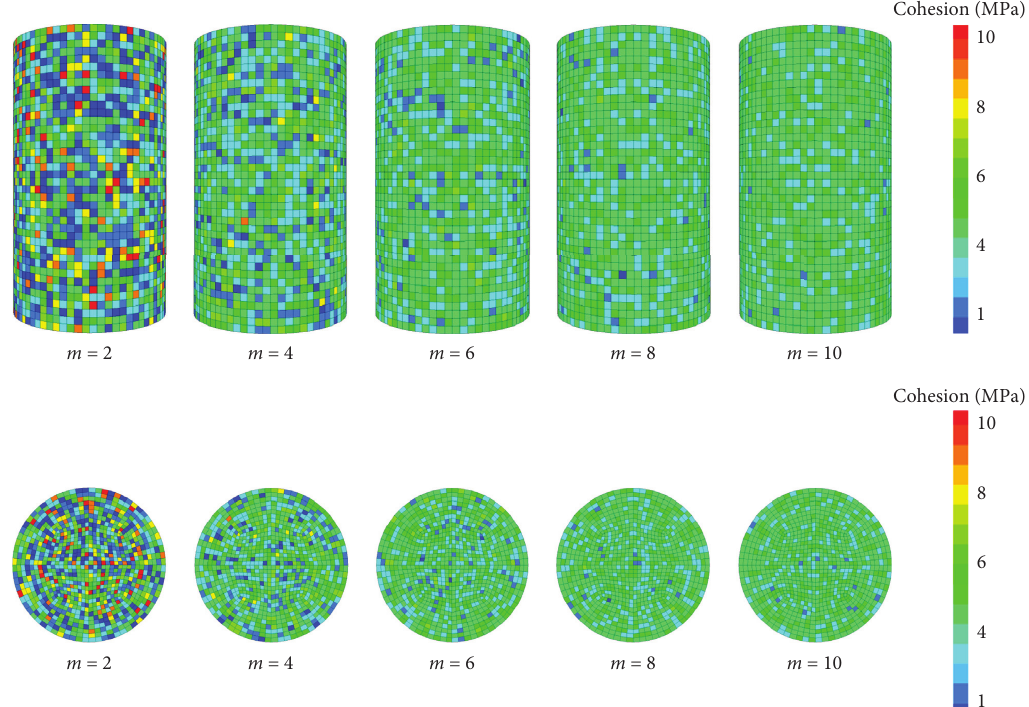
Figure 14: Random assignment of cohesion in the numerical model by Weibull function with different parameter m .